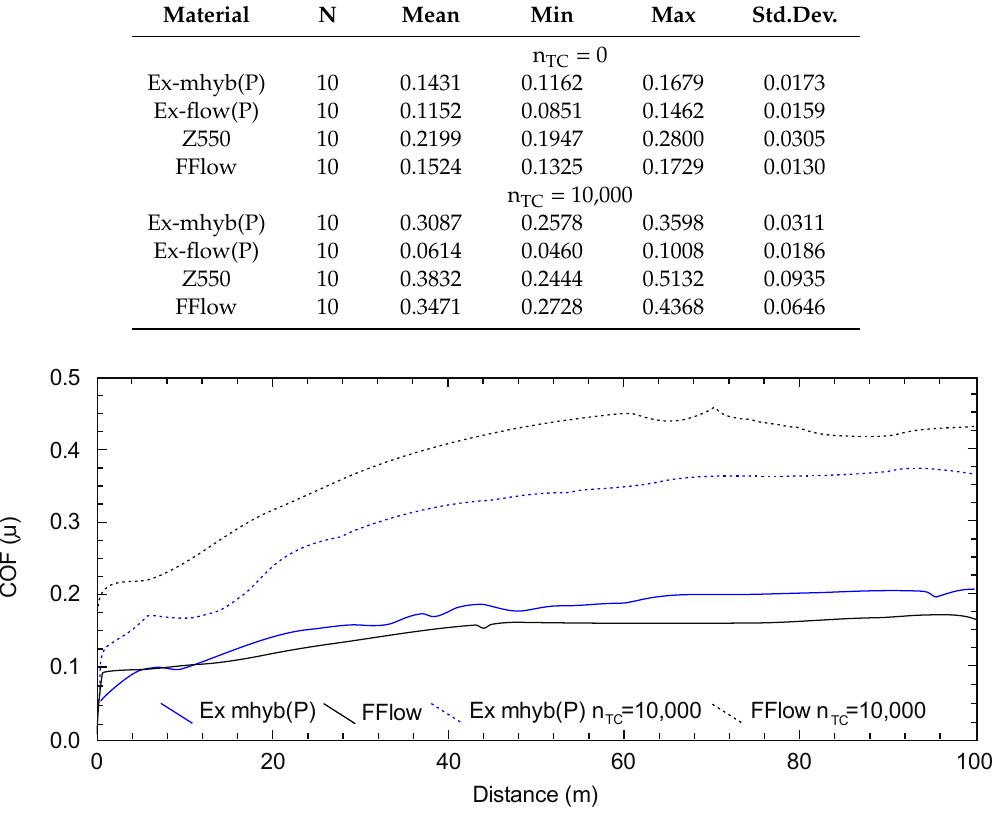
Table 3. Test results of friction coe ffi cient.